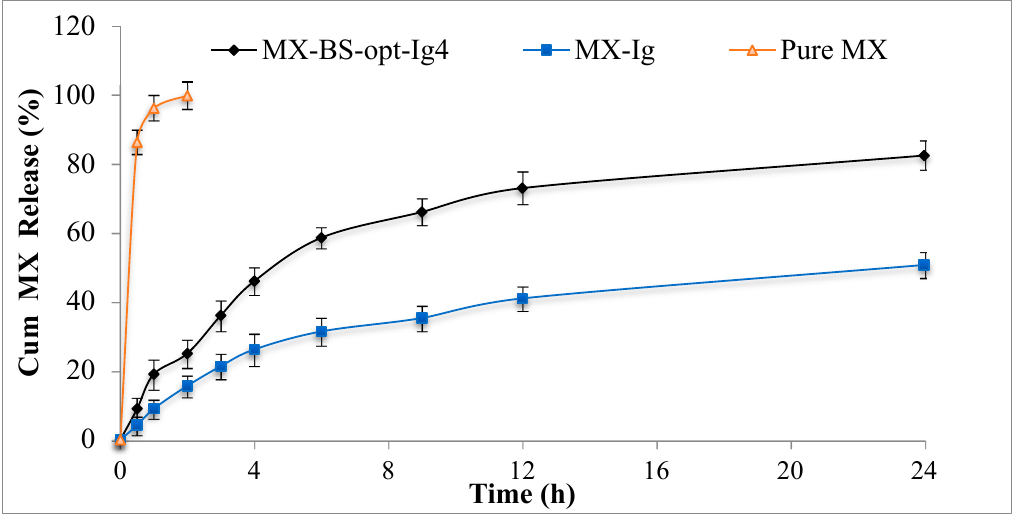
Figure 8. In vitro drug release profiles of MX from moxifloxacin-loaded bilosome in situ gel (MX- BSop-Ig4), moxifloxacin in situ gel (MX-lg), and pure MX solution. The study was performed in triplicate, and data are shown as mean ± SD.